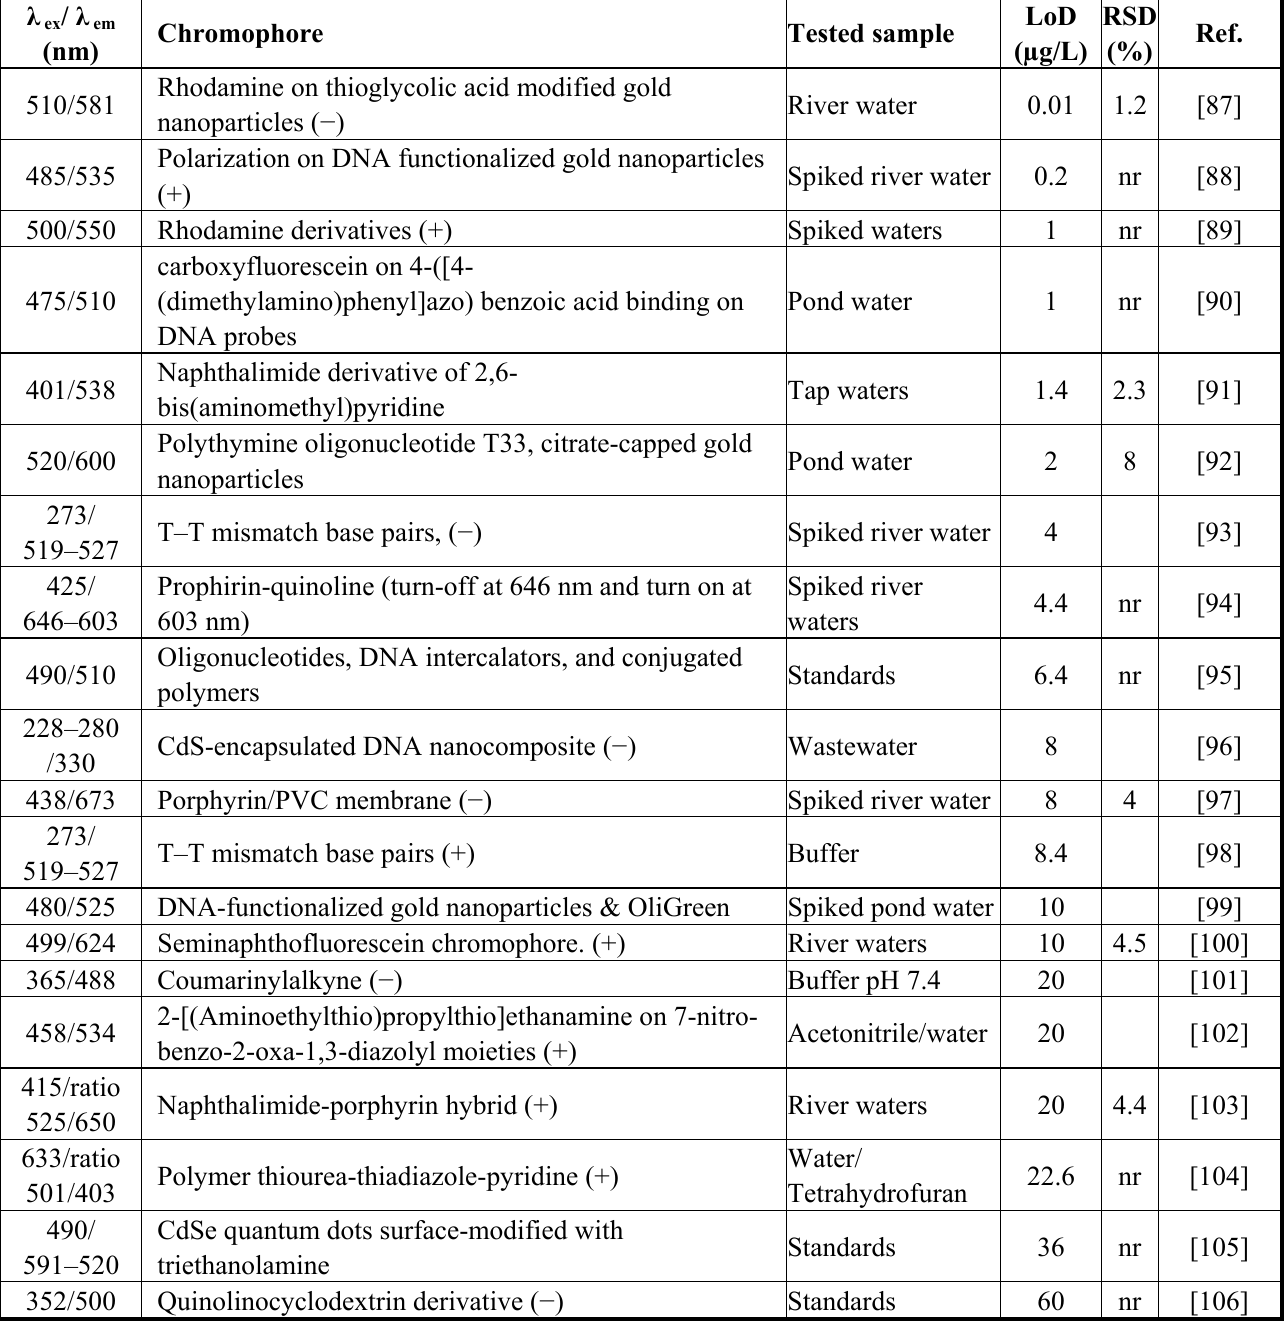
Table 5. Analytical characteristics of fluorimetric sensors for mercury determination in water, published between 2007 and